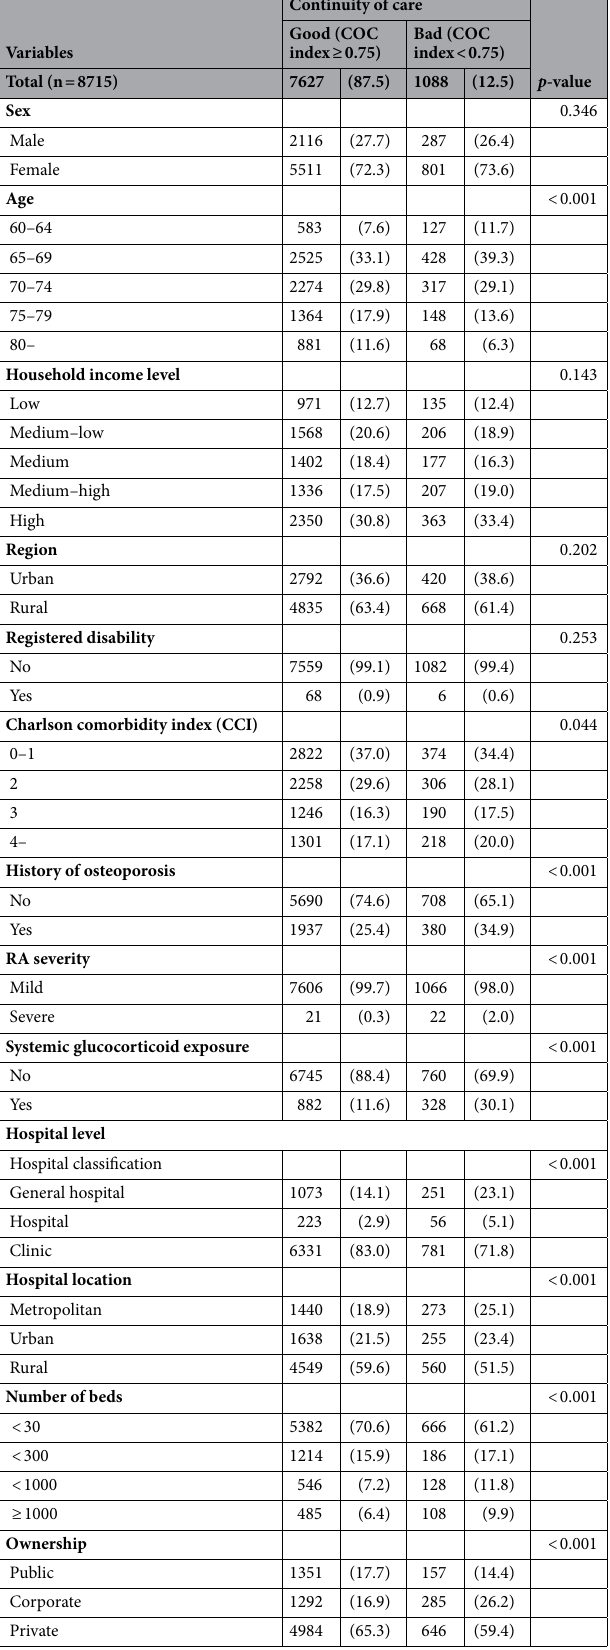
Table 1. Baseline characteristics according to level of continuity of care. Values are presented as number (%). COC continuity of care. p -values were obtained by Chi-square